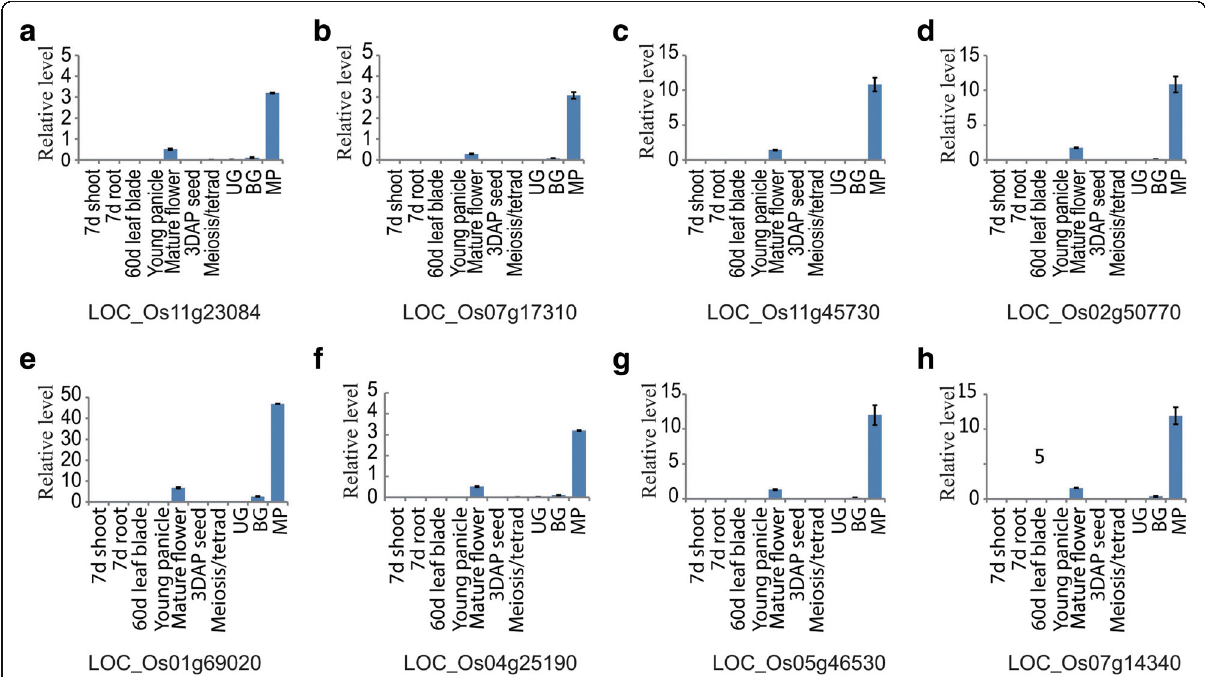
Fig. 3 Real-time RT-PCR analysis of 8 genes shown in Fig. 2. Expression patterns of LOC_Os11g20384 ( a ), LOC_Os07g17310 ( b ), LOC_Os11g45730 ( c ), LOC_Os02g50770 ( d ), LOC_Os01g69020 ( e ), LOC_Os05g46530 ( f ), LOC_Os07g14340 ( g ), and LOC_Os04g25190 ( h ) were analyzed by quantitative real-time PCR for various organs. Transcript levels were normalized to rice Ubi5 and calculated by comparative cycle threshold method. Error bars indicate standard deviation (sd). y-axis, relative expression level to rice Ubi5 ; x-axis, sample names used for analyses. 3DAPS, seeds at 3 d after pollination; 7DS, 7-day-old shoots; 7DR, 7-day-old roots; ML, mature leaves; MF, mature flower; YP, young panicles (2 cm long); and anthers at bi-cellular gametophyte stage (BG); tri-cellular mature pollen stage (MP); meiosis and tetrad (M/T); and uni-cellular gametophyte stage